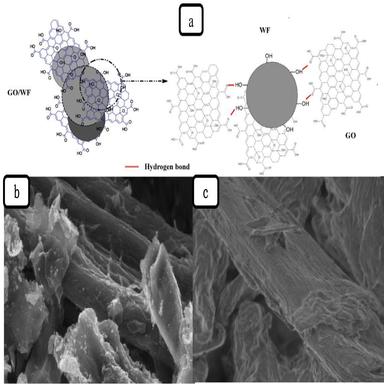
(a) Schematic illustrations molecular structures of WF/GO composite, (b) and (c) SEM images of WF/GO composite.